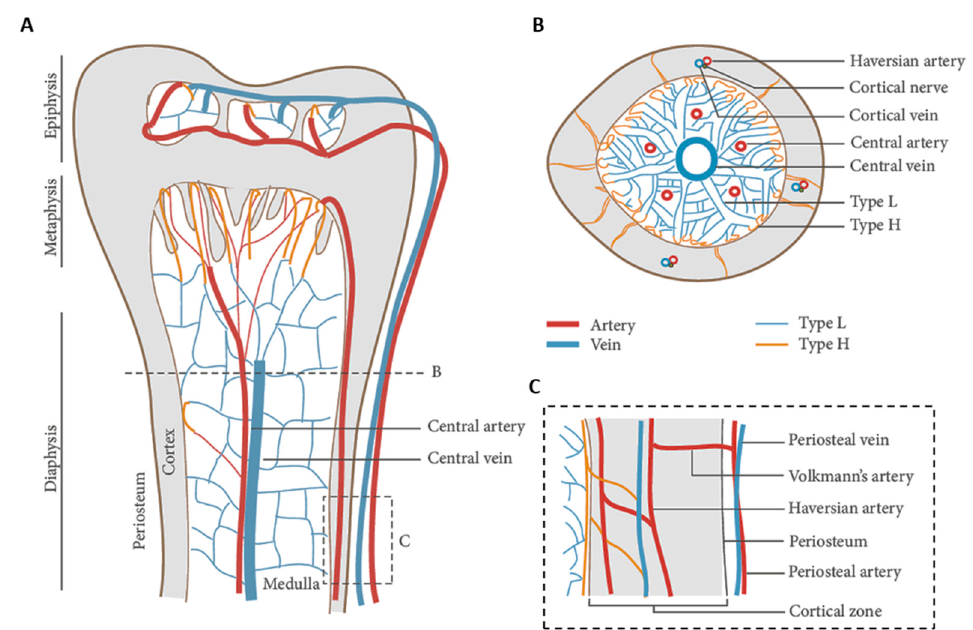
Figure 9. Blood vessel arrangement in long bones: ( A ) longitudinal view showing arteries branching into H type capillaries, and veins branching into L type capillaries in the epiphysis, metaphysis, and diaphysis; ( B ) cross view showing a main central vein and a few arteries in the medullary region; and ( C ) zoomed-in panel showing the connection between cortical and medullary blood flow. Adapted from [111] and reused under Creative Commons Attribution (CC BY) license.